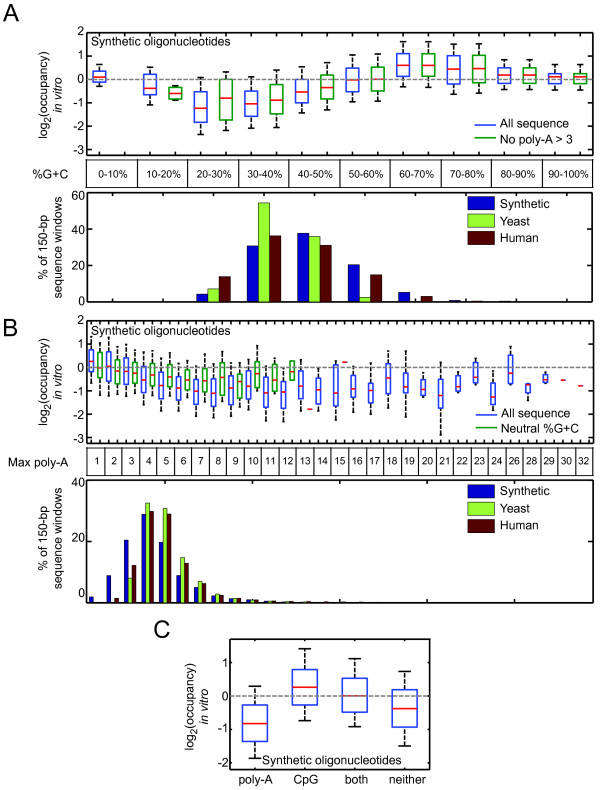
Relative nucleosome preference of different subsets of synthetic 150-mers. (A) and (B) Dependence of relative nucleosome preference (as log2(occupancy ratio)) on G+C content (A) and maximum poly-A length (B). Oligonucleotides categorized as "Neutral %G+C" in (B) are those with 45-55% G+C. Graph below shows the frequency of the selected attribute in the oligonucleotides analyzed, and also the human and yeast genomes. (C) Dependence of relative occupancy on poly-A content and CpG status. Poly-A containing oligonucleotides are defined as containing at least four consecutive adenine bases. CpG oligonucleotides are defined as having a G+C content ≥50%, with an observed/expected CpG ratio ≥0.6 (Obs/Exp CpG = Number of CpG * N/(num G * num C), where N = length of sequence[37]). The sequencing readout (rather than array readout) data from the Kaplan paper was used in this analysis. On all box plots, whiskers indicate 10th and 90th percentiles.